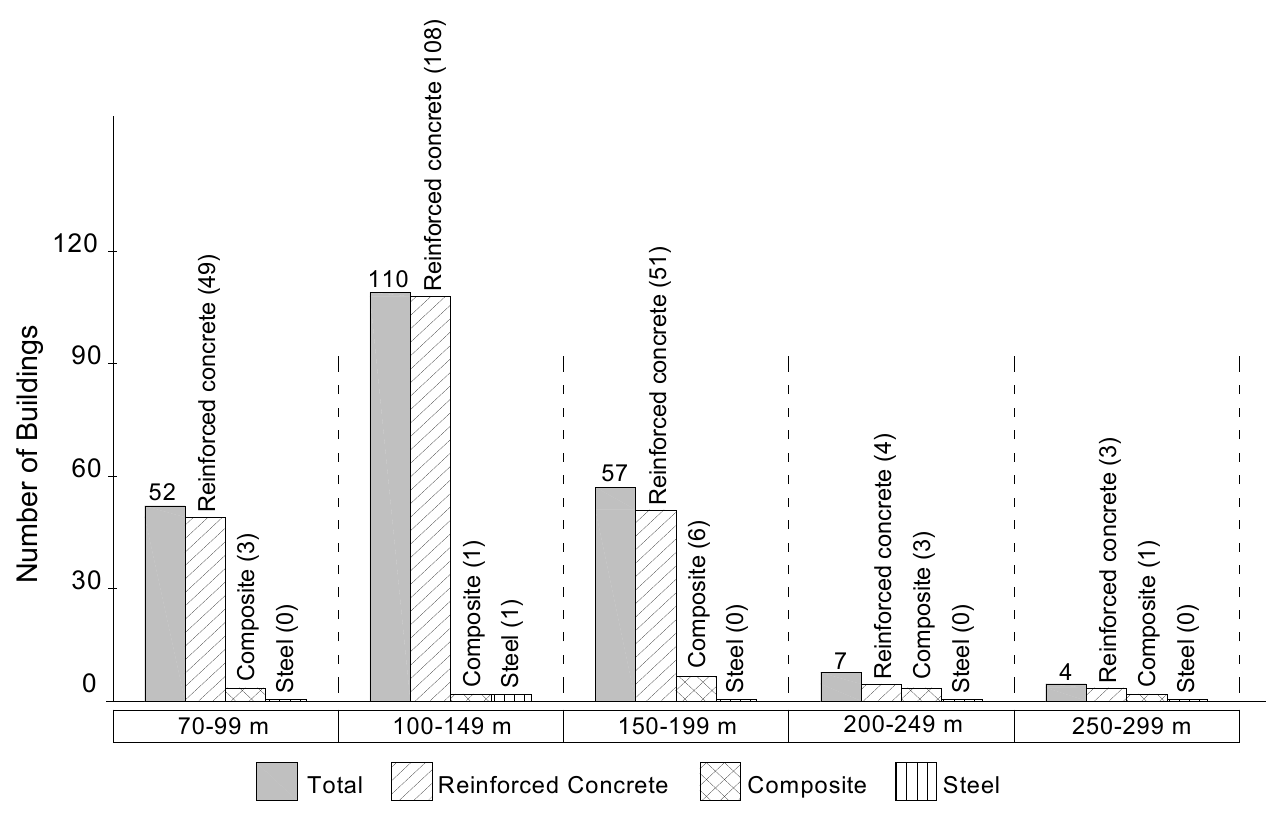
Figure 18. Relation between building height and building material.